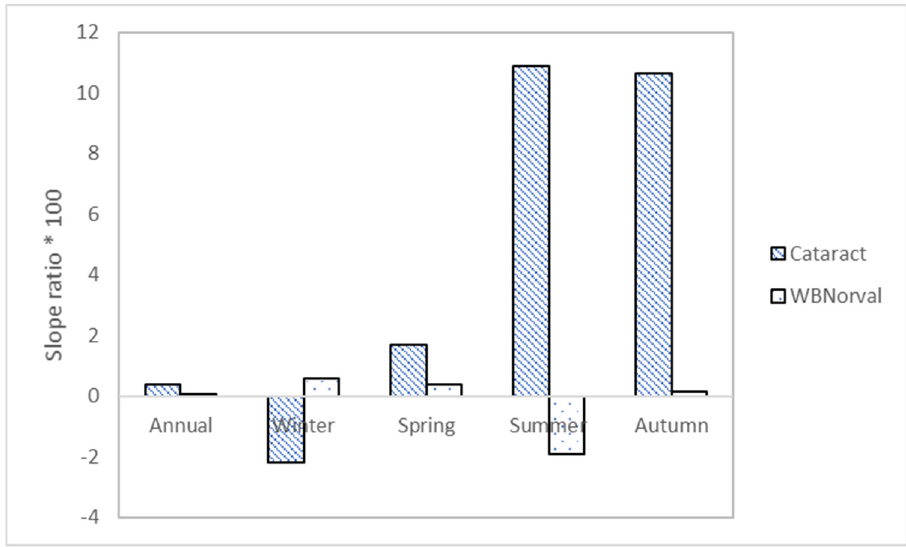
Figure 12. Cataract and WB Norval annual and seasonal streamflow changes normalized with the precipitation for the period 1971–2019. The change for the urban gauge is negative.